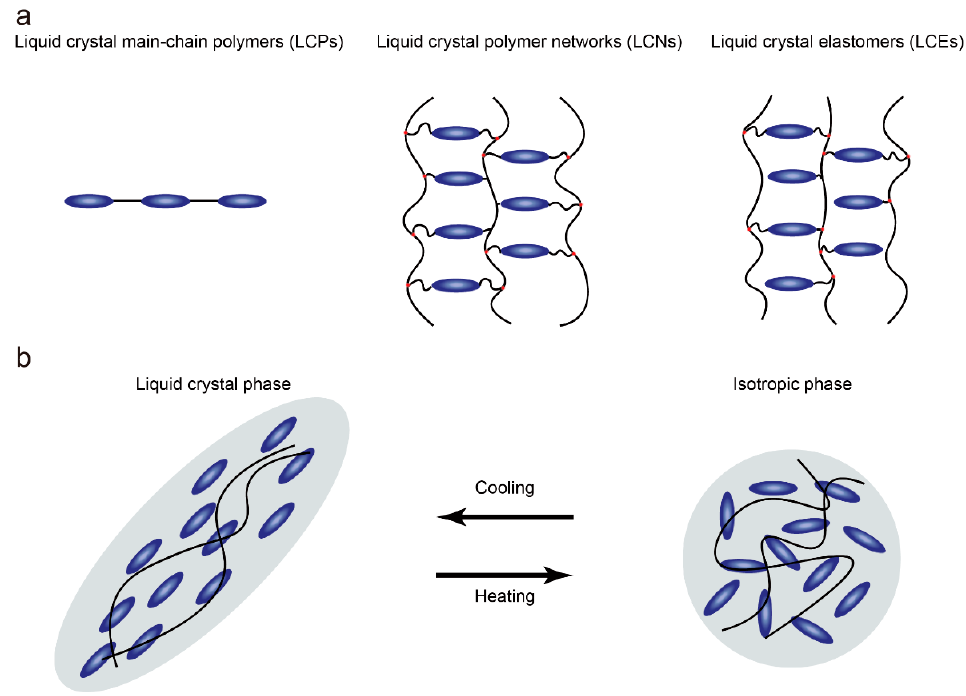
Figure 1. ( a ) Schematic of liquid crystal polymers, liquid crystal polymer networks and liquid crystal elastomers; ( b ) Schematic illustration of the contraction along the alignment of LCEs when heated beyond T NI .